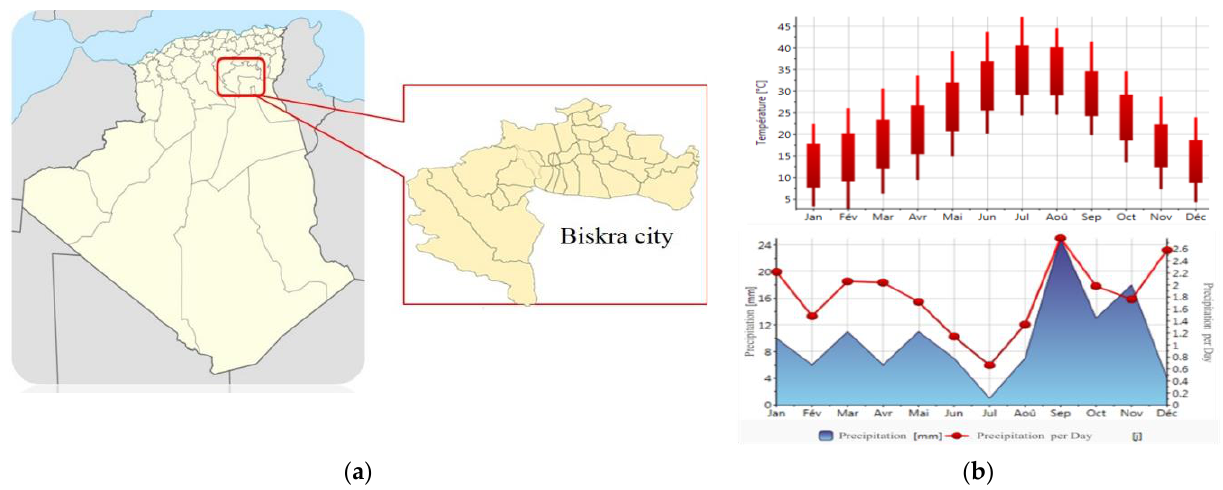
Figure 2. ( a ) Location of Biskra in Algeria. ( b ) Monthly average temperature in °C, and monthly average precipitations in mm (period from 2010 to 2020).